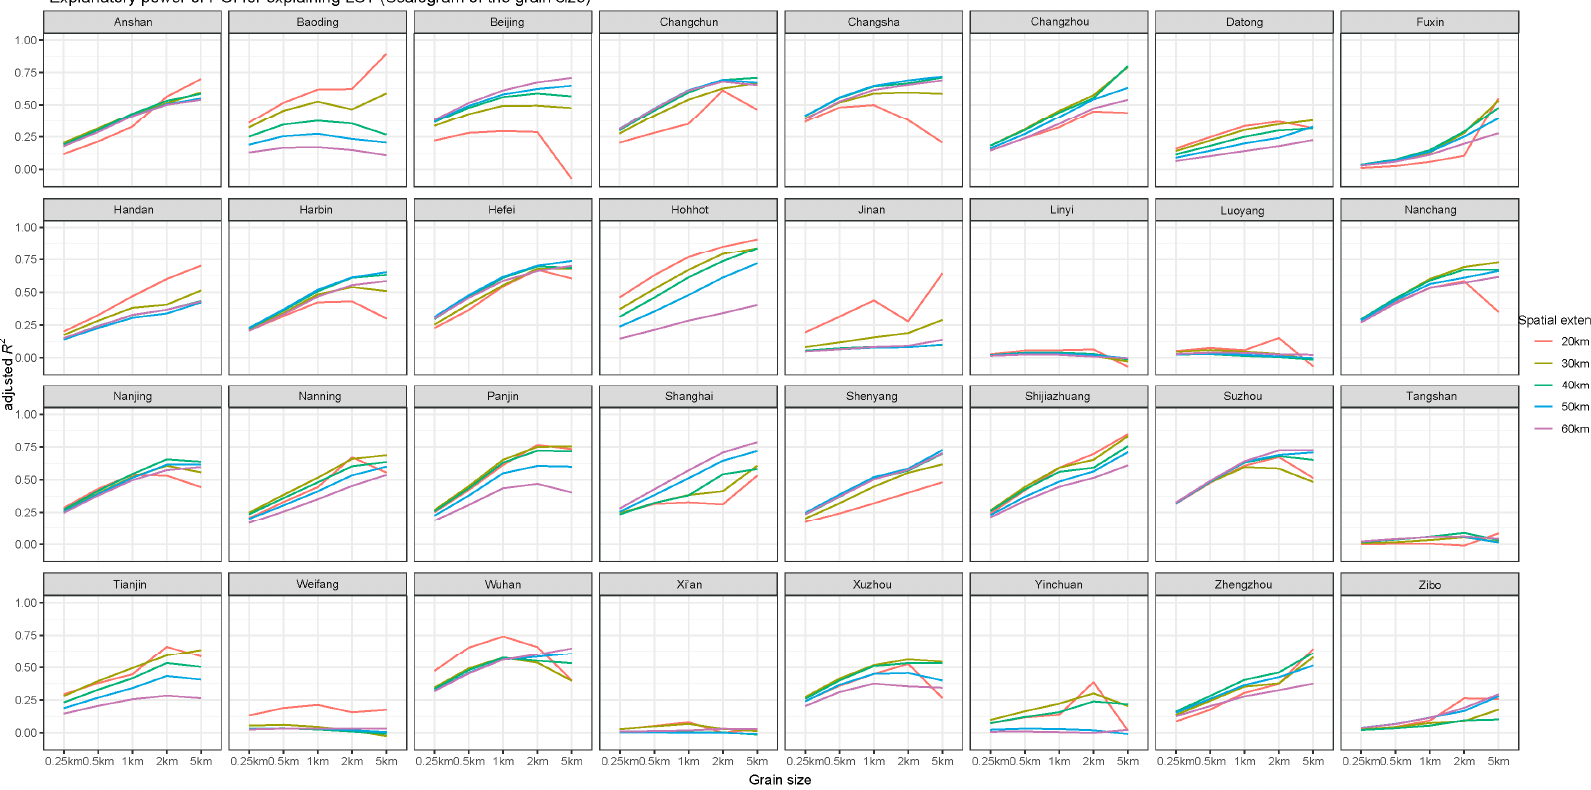
Figure A7. Explanatory power of POI for explaning LST(Scalogram of the grain size).